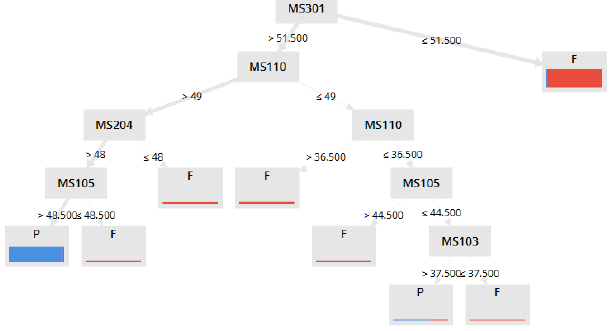
Fig. 10. Decision tree with Gini index for dataset 1